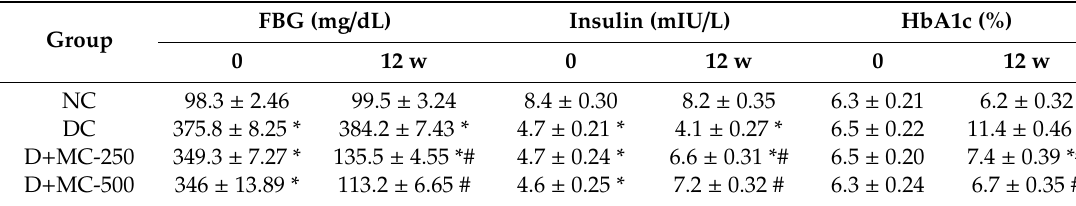
Table 1. E ff ect of Momordica charantia (MC) on blood levels of glucose, insulin, and glycosylated hemoglobin (HbA1c) of streptozotocin (STZ)-induced diabetic male rats. FBG, fasting blood glucose; NC, normal control; DC, diabetic control; D + MC-250, MC 250 mg / kg b.w. treatment; D + MC-500, MC 500 mg / kg b.w. treatment.